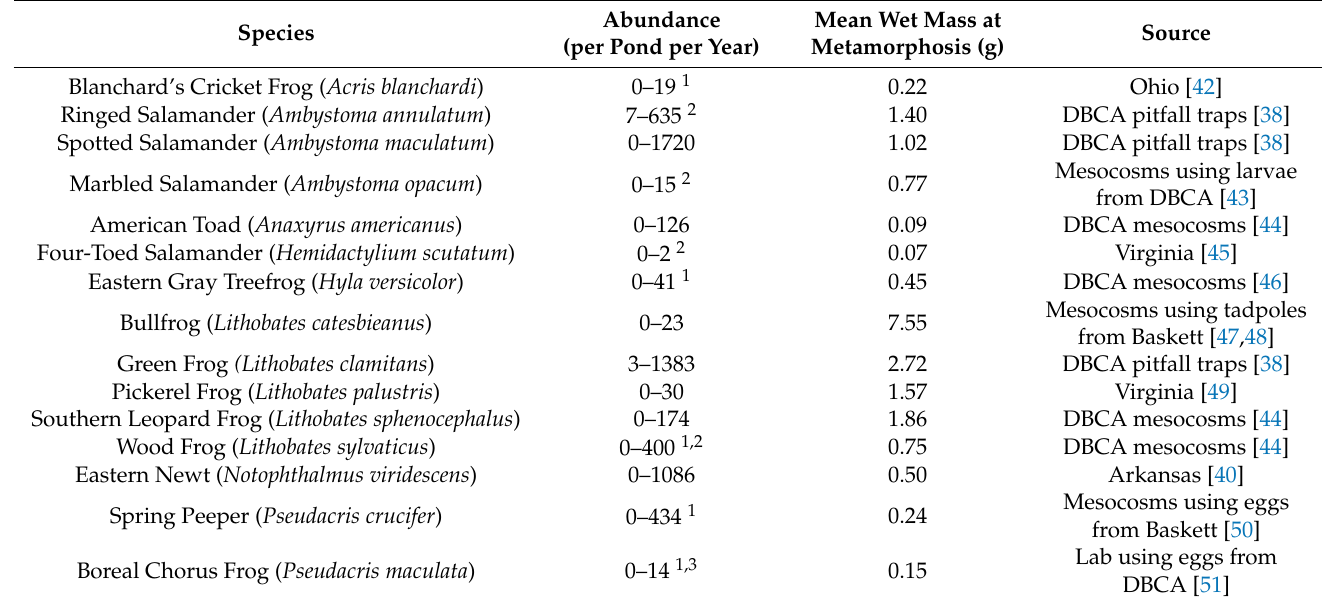
Table 2. Recently metamorphosed species produced by Missouri ponds, range of abundance per pond per year, mean wet mass at metamorphosis used in biomass estimates, and the source for individual mass